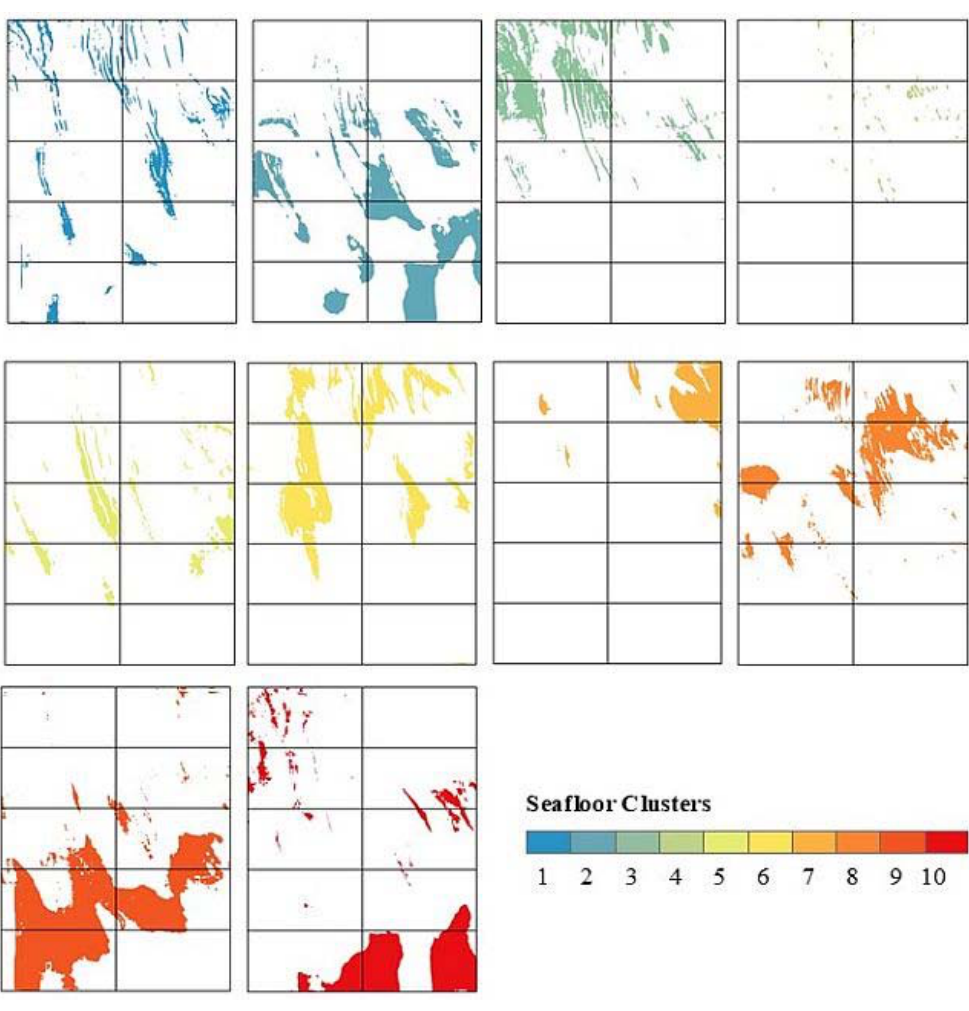
Figure A6. Seafloor clusters within each spatial block; at least one cluster is absent in each of the spatial blocks. This causes spatial-CV extrapolation, which creates results such as the cluster-CV approach.